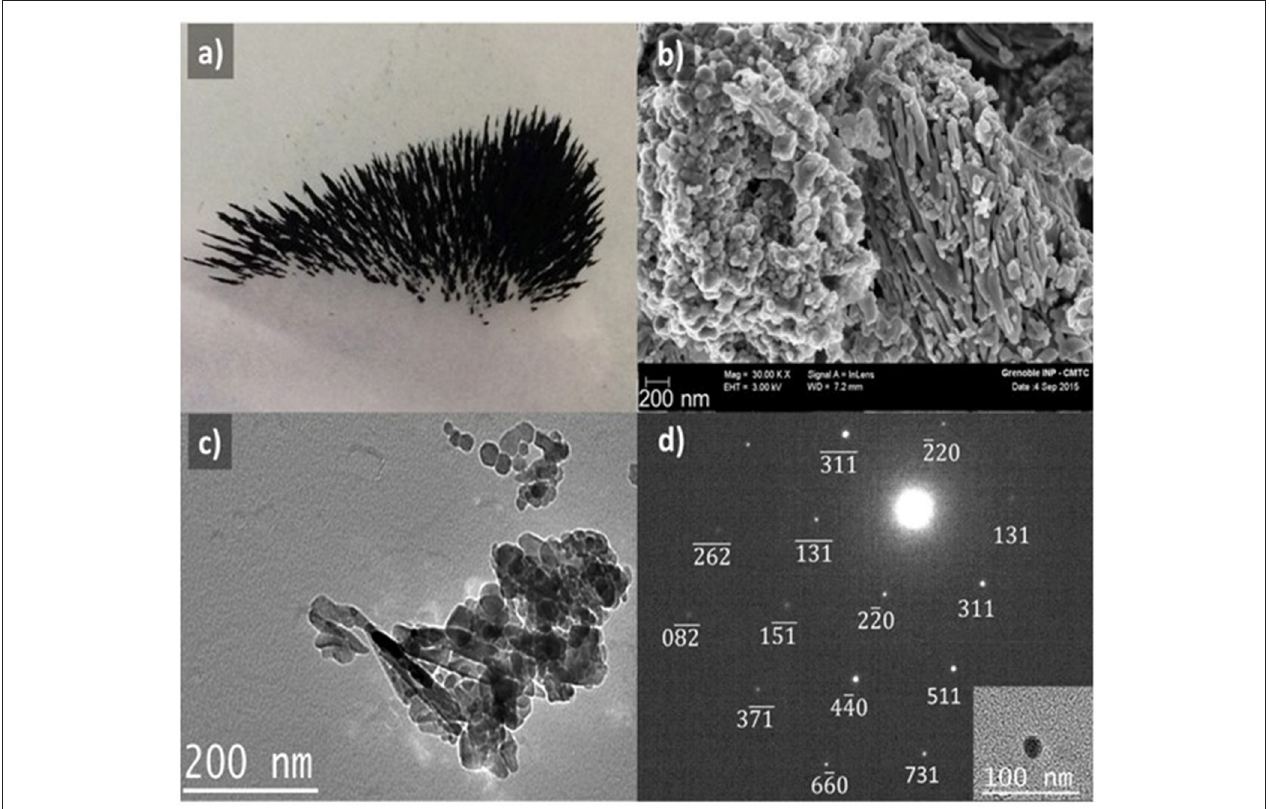
FIGURE 5 | Observation of magnetic particles after separation from APW-300C sample; (a) optical image (with a total length of about 5 cm); (b) FE-SEM and (c) TEM images; (d) Electron micro-diffraction pattern of an isolated magnetite nanoparticle visible in the lower-right panel with the corresponding scale